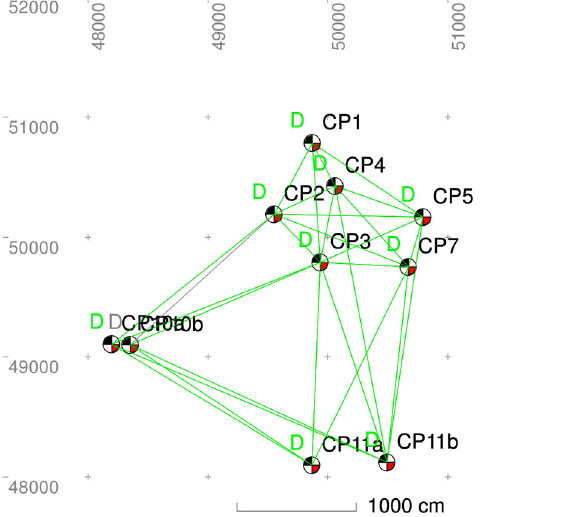
Figure 6. Processing of the measure took underwater of GCP by coordinates. Site Surveyor software.